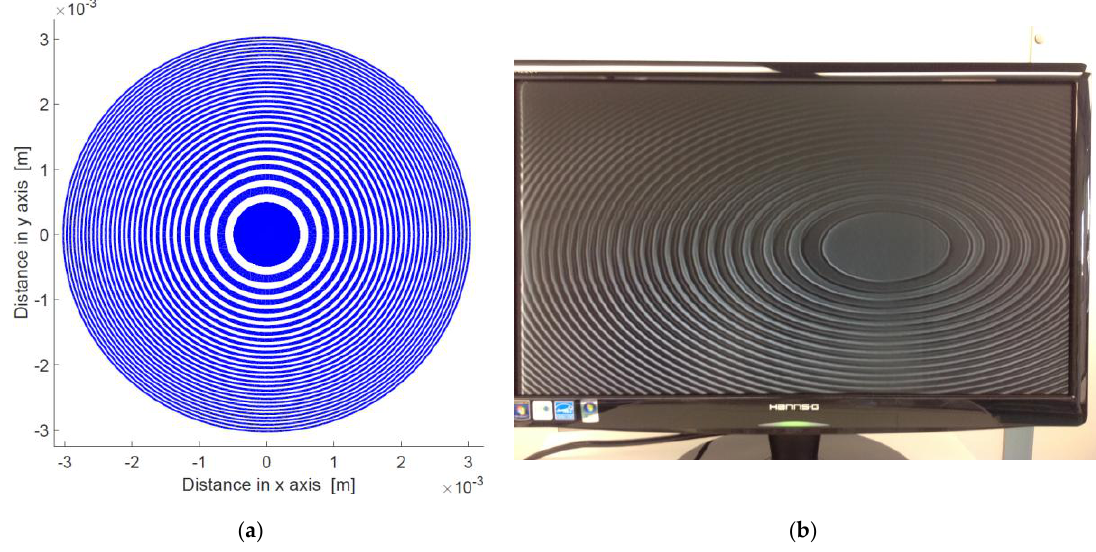
Figure 3. ( a ) MATLAB Simulation of first few BZP zones. ( b ) BZP viewed under microscope.